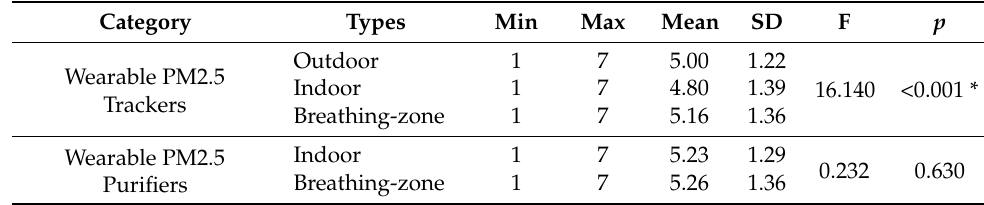
Table 4. Comparison of different types of wearable